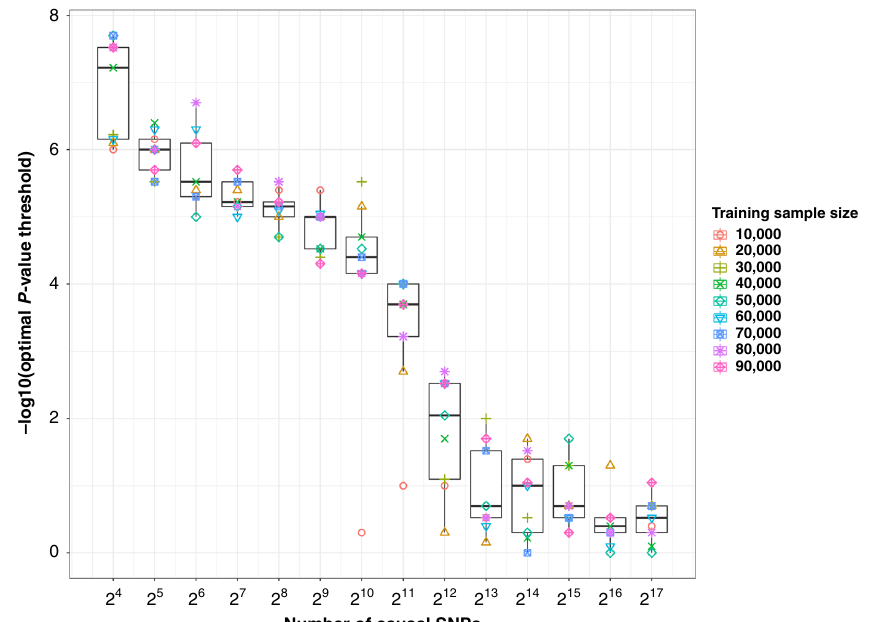
Fig. 3 The relationship between optimal GRS P- value threshold and number of causal SNPs. Causal SNPs were selected from 1,037,804 HapMap3 SNPs. For each scenario, we generated a phenotype of 100,000 individuals based on a speci fi ed number of causal SNPs (e.g., 128) with heritability 0.09. We randomly selected 10,000 individuals as the test set. Based on the unselected individuals, we randomly chose 10,000, 20,000, 30,000, 40,000, 50,000, 60,000, 70,000, 80,000 and 90,000 individuals separately as training sets and used them to perform GWAS. We examined the performance of genetic risk score (based on LD clumping with 80 separate P- value thresholds) on the test set ( N test = 10,000) and selected the optimal P- value threshold. Box plot shows the median (centre line), the interquartile range (box) and whiskers (±1.5 times interquartile